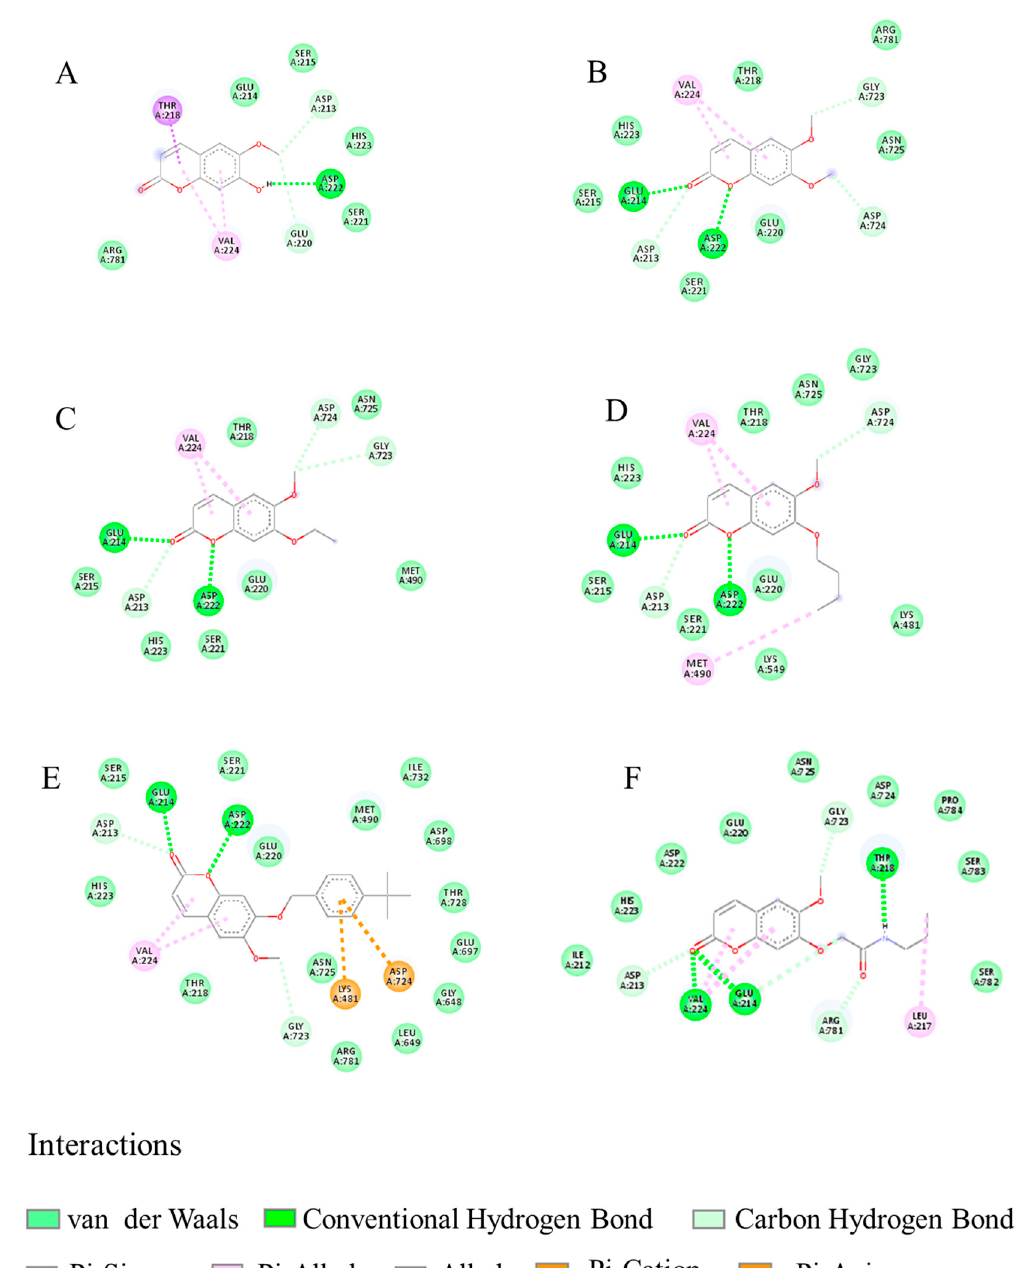
Figure 8. Two dimensional interactions scheme of scopoletin ( A ) and compounds 8 ( B ), 9 ( C ), 12 ( D ), 20 ( E ), and 28 ( F ) to TcPMCA1 .